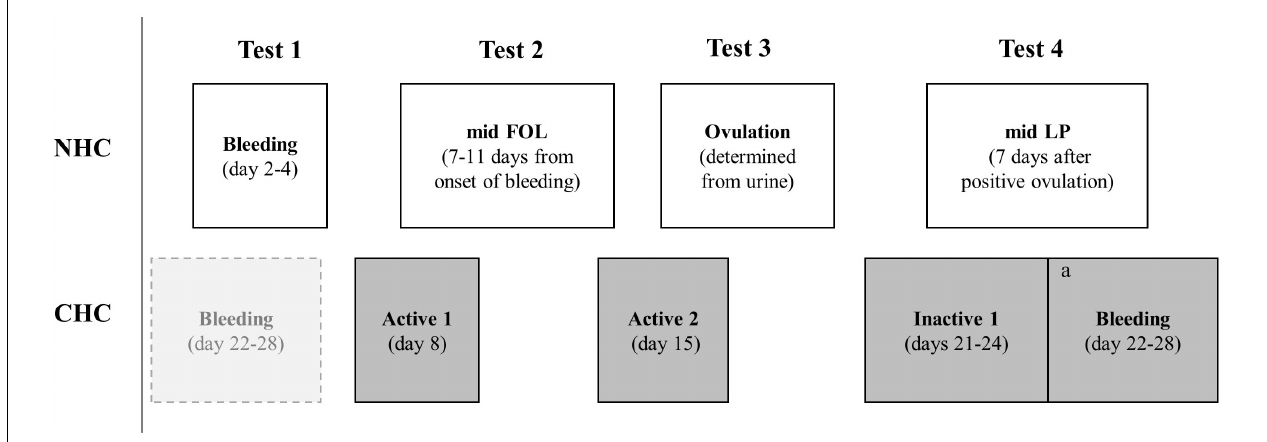
FIGURE 1 | Overview of the timing of incremental treadmill testing in the eumenorrheic (EUM) participants and the monophasic hormonal contraceptive users (CHC). a = 3–6 days of habitual physical activity or active rest separated inactive 1 and bleeding tests.